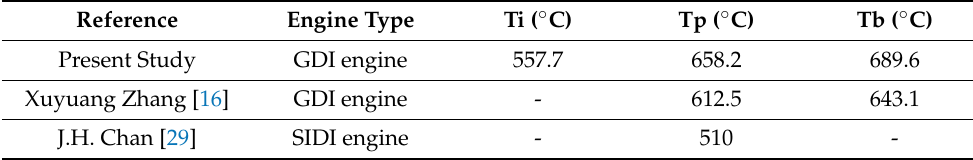
Table 5. Initial combustion characteristics of